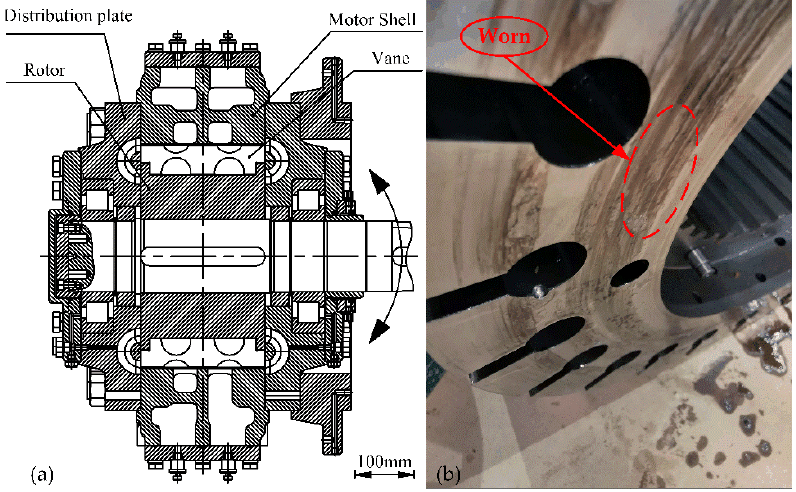
Figure 1. ( a ) The HNM-STS type vane hydraulic motor; ( b ) the worn surface of the rotor. Two types of metallic materials, QT500-7 (GB/T1348-2009) and LC2-1 (JB/T 7248- 2008), can be used to make cryogenic valves and hydraulic components. In this study, these materials were processed into pin samples. The material QT350-22L (ISO 1083:2004), which was determined to be a distribution plate, was processed into disc samples. The